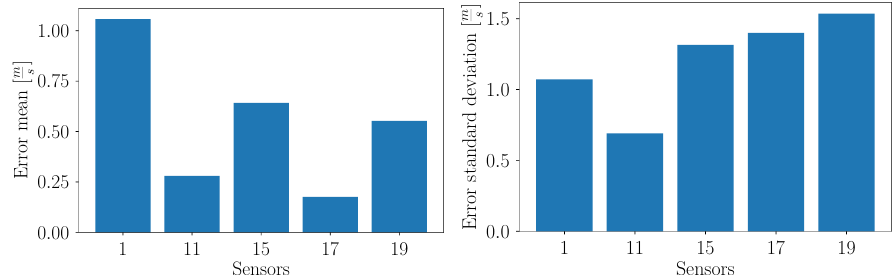
Figure 39. Mean and standard deviation of each sensor error for the standard